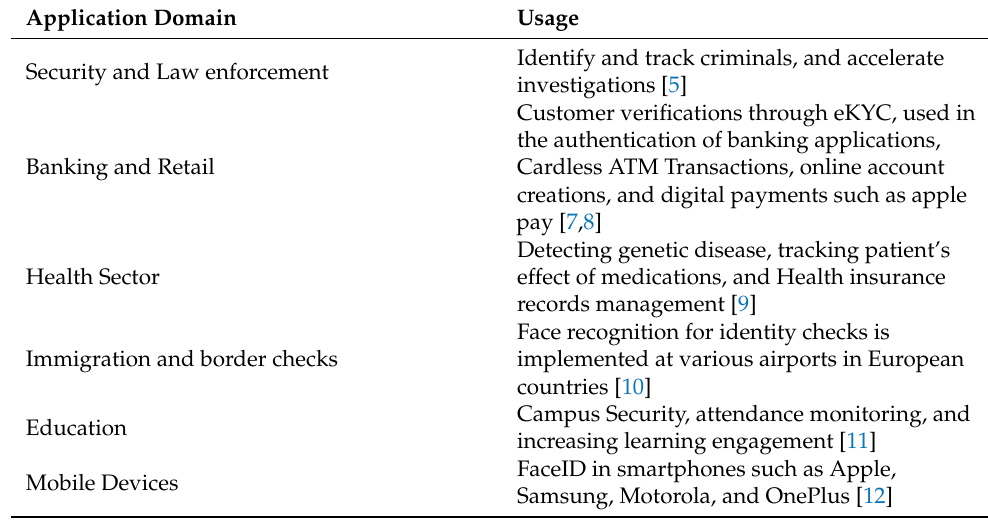
Table 1. Several application domains for facial biometric